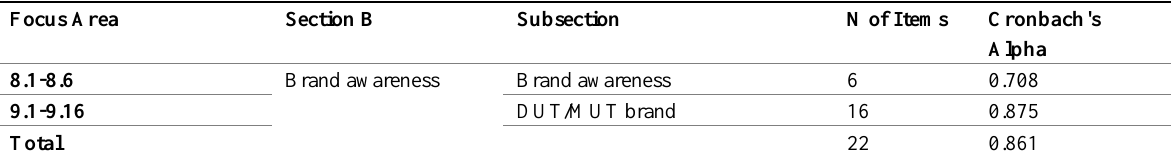
Table 7: Reliability assessment for brand awareness